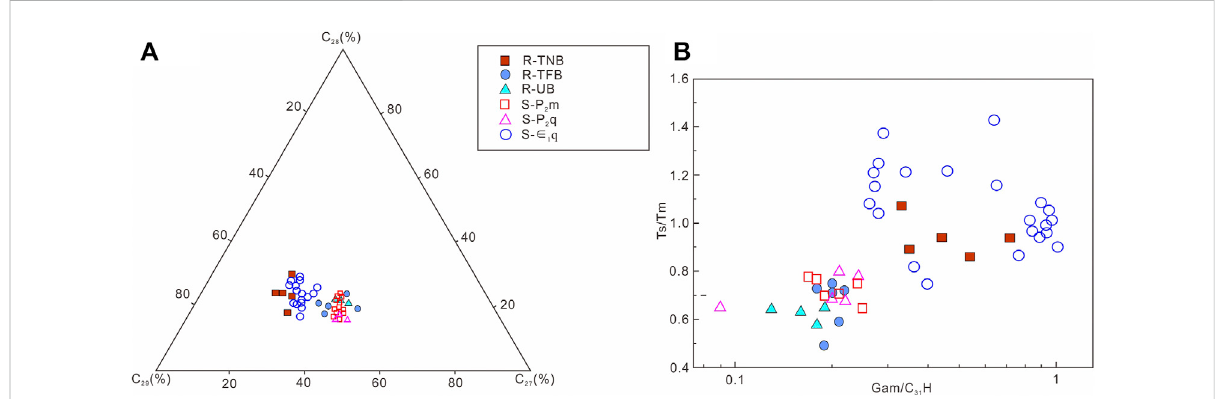
FIGURE 8 Biomarker characteristics for source rocks in different stratigraphic intervals and reservoir solid bitumen in different structural belts for determining the origins of natural gas (modi fi ed by Li et al., 2022). (A) Ternary plot of C 27 – C 28 – C 29 steranes. (B) Cross plot of Gam/C 31 H vs. Ts/Tm.